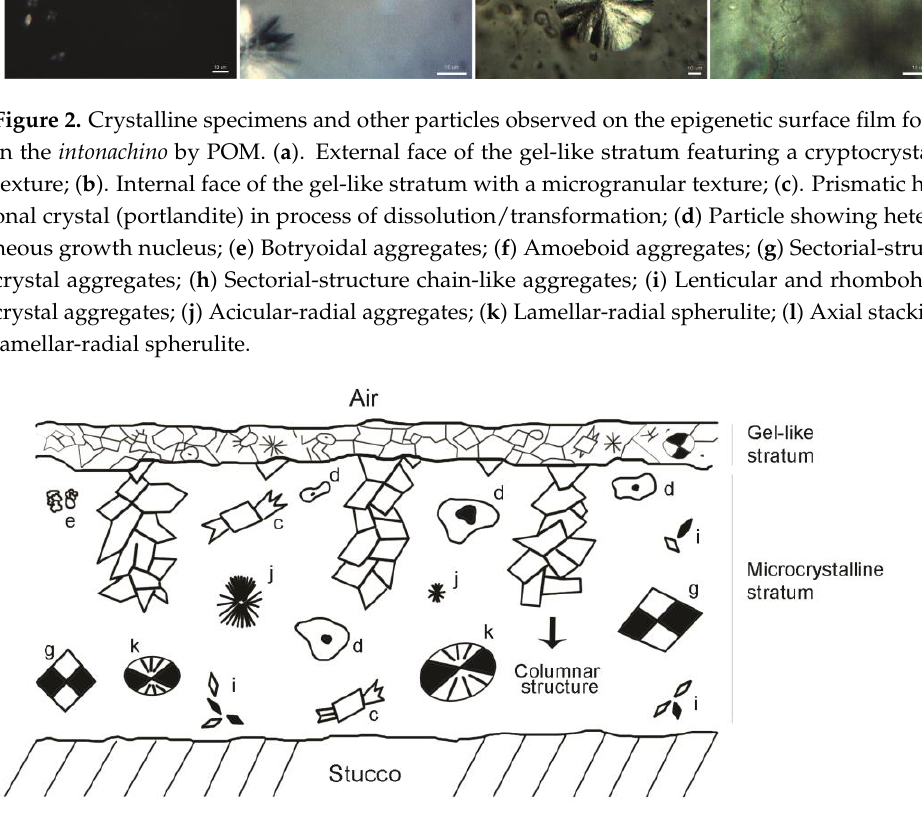
Figure 3. Sketch of the epigenetic superficial film in section. Letters correspond to the crystalline phases and other particles shown in Figure 2 (modified from [29]). Note that although the gel-like stratum is mainly composed of sub-micron particles of calcium carbonate (vide infra) , some of the crystallochemical phases identified in the microcrystalline stratum may be also present in the outer- most layer. Letters correspond to crystalline specimens and other particles shown in Figure 2.